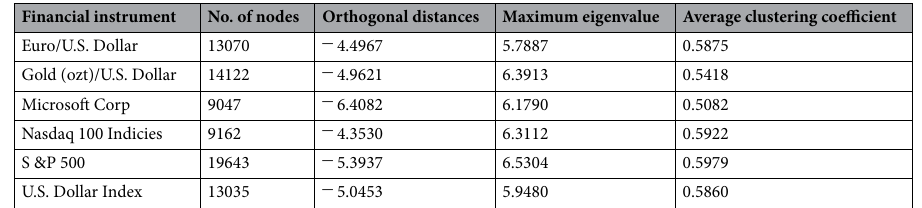
Table 2. General properties of the financial TS HVGs.